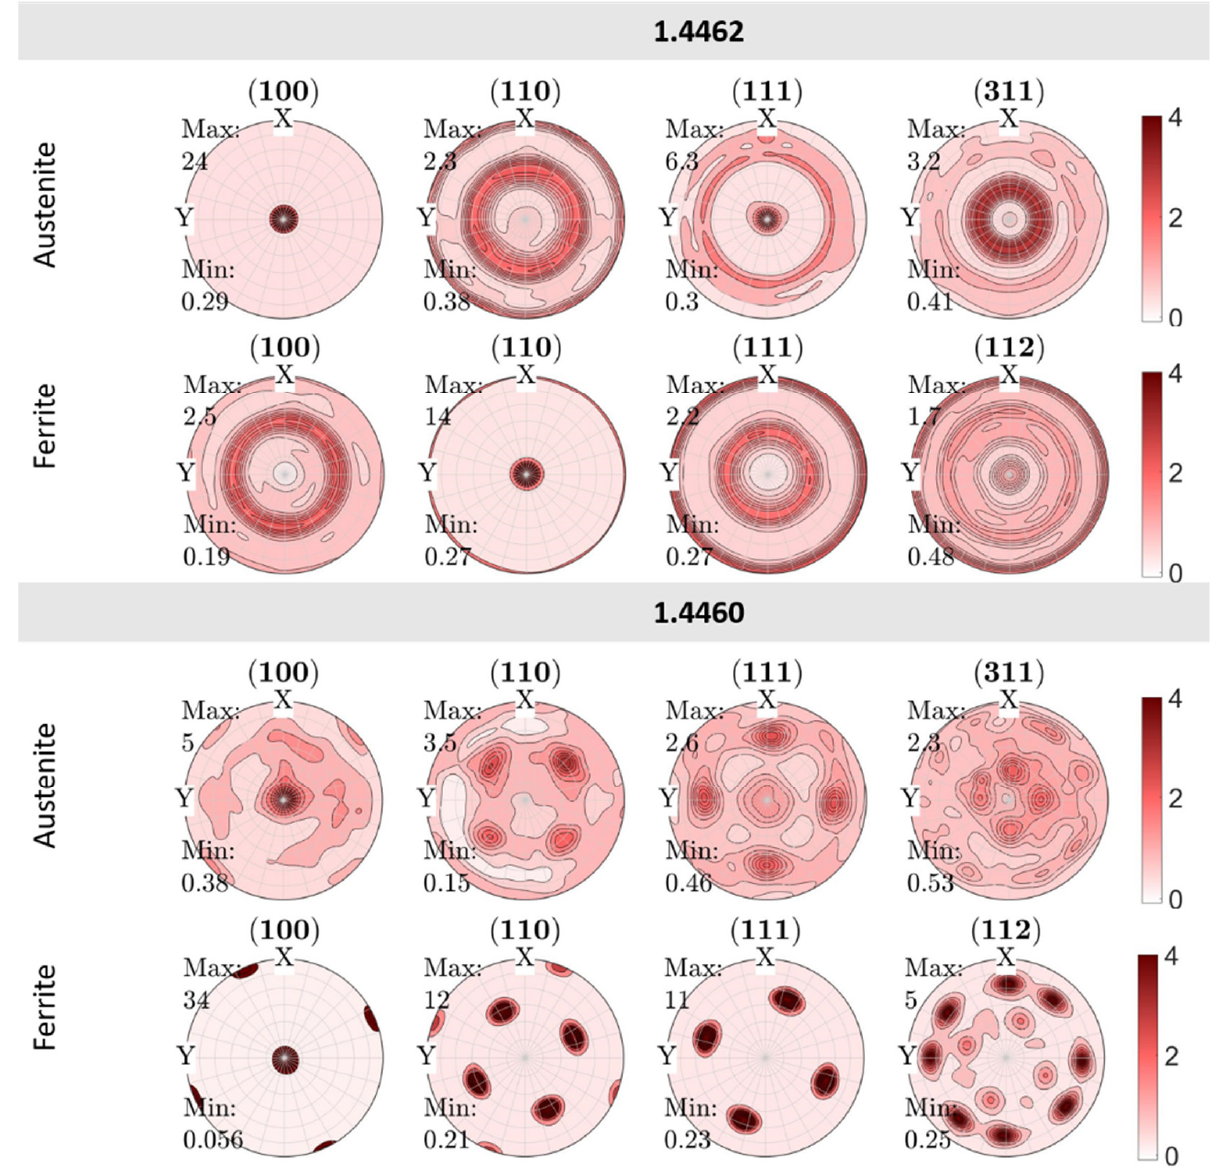
Figure 2. Initial textures represented by the back-calculated pole figures. The x- and y-axes corre- spond to the transverse directions of the sample. The normal direction (z-axis) corresponds to the longitudinal direction of the sample and was parallel to the load direction in the tensile test. The upper two rows show the phase-specific texture in the sample cross-section for 1.4462 duplex stainless steel. The lower two rows, on the other hand, show that for the 1.4460 duplex stainless steel. Pole figures of four different lattice planes were recalculated from the phase-specific ODFs for both duplex stainless steels. The axis label correlates with the intensity distribution in relation of a random density distribution of the recalculated pole figure. The legend was scaled to 4 regardless of the present maximum intensity to allow for the recognition of small texture gradients. In addition, the pole-figure-specific maximum and minimum values of the recalculated intensity distribution were plotted together with each individual pole figure.